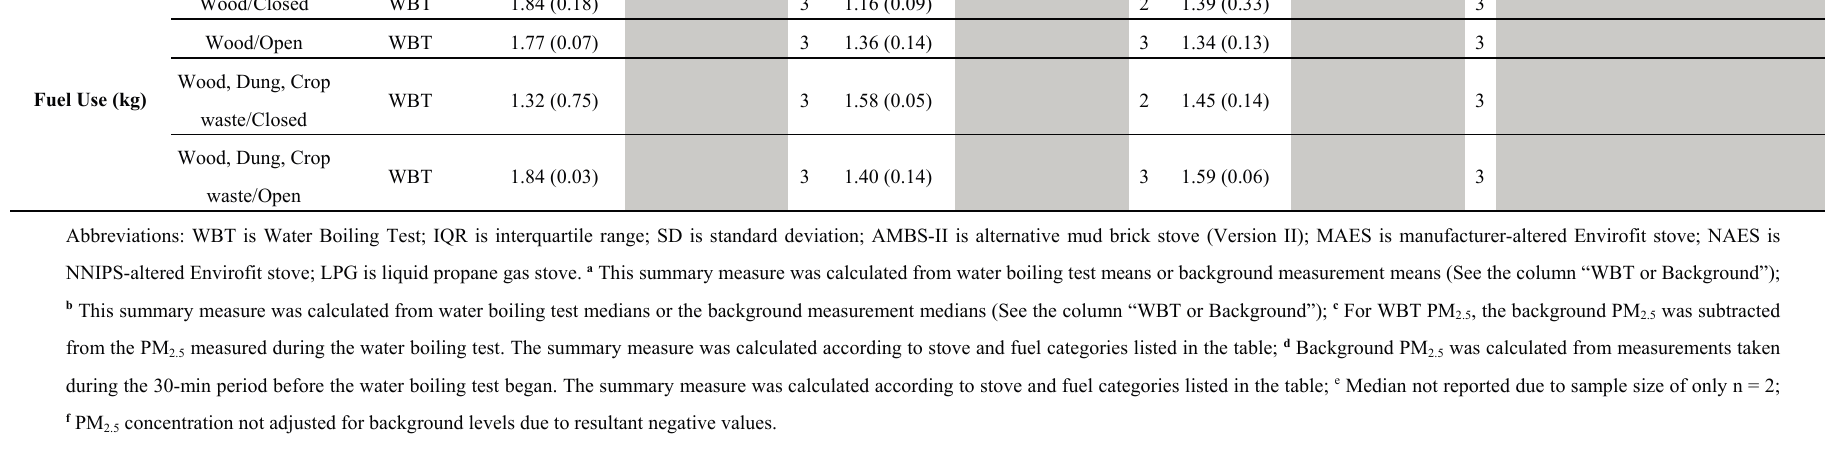
Table 5. Multivariate analysis a of cookstove performance in Study II comparing three alternative cookstoves to an Improved Mud Brick Stove in a home setting in rural